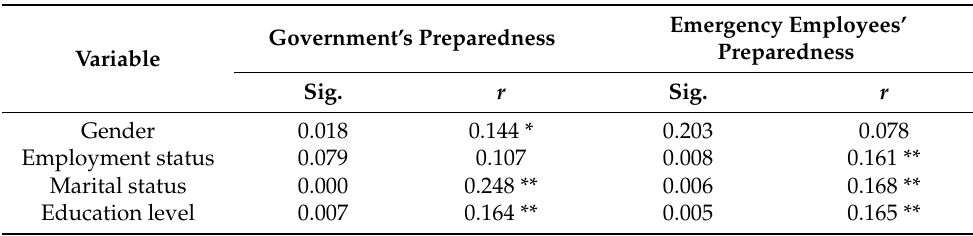
Table 5. Perception of the participants; Pearson’s correlation between government’s and emergency employees’ preparedness and the